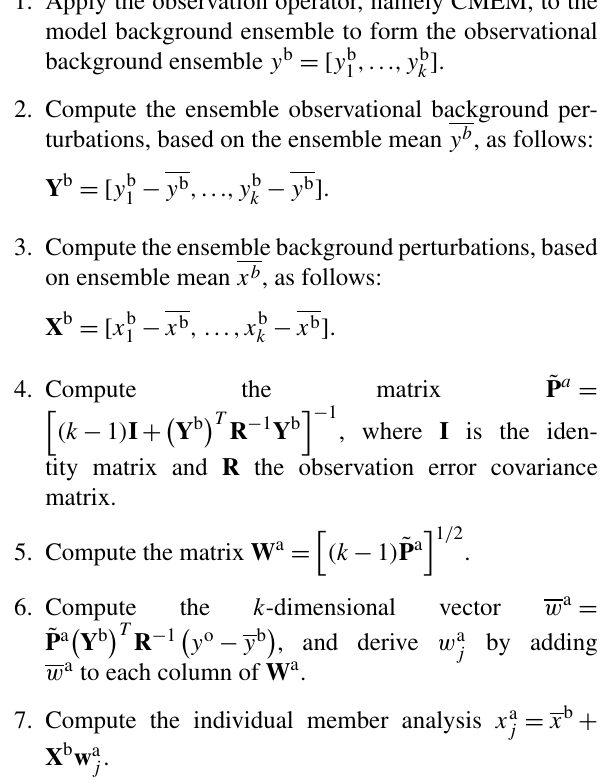
Across 10 soil layers (adapted Richards equation) Across two soil layers (power law